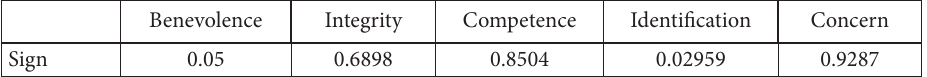
Table 5. P-values of the Kruskal-Wallis test with respect to age (source: own research)